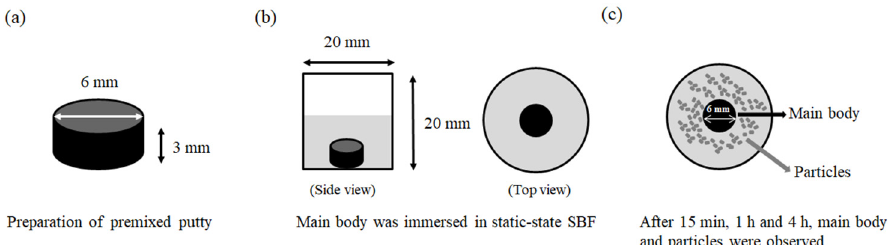
Figure 1. Schematic diagram of washout resistance test. ( a ) Premixed putty mold, 6 mm in diameter and 3 mm in height, to make a cylindrical shape. ( b ) Premixed putty main body immersed in static- state SBF (gray area) at 37°C (top view). ( c ) After 15 min, 1 h, and 4 h, the main body and particles were observed, and the main body was identified as 6 mm in diameter, and particles (top view).